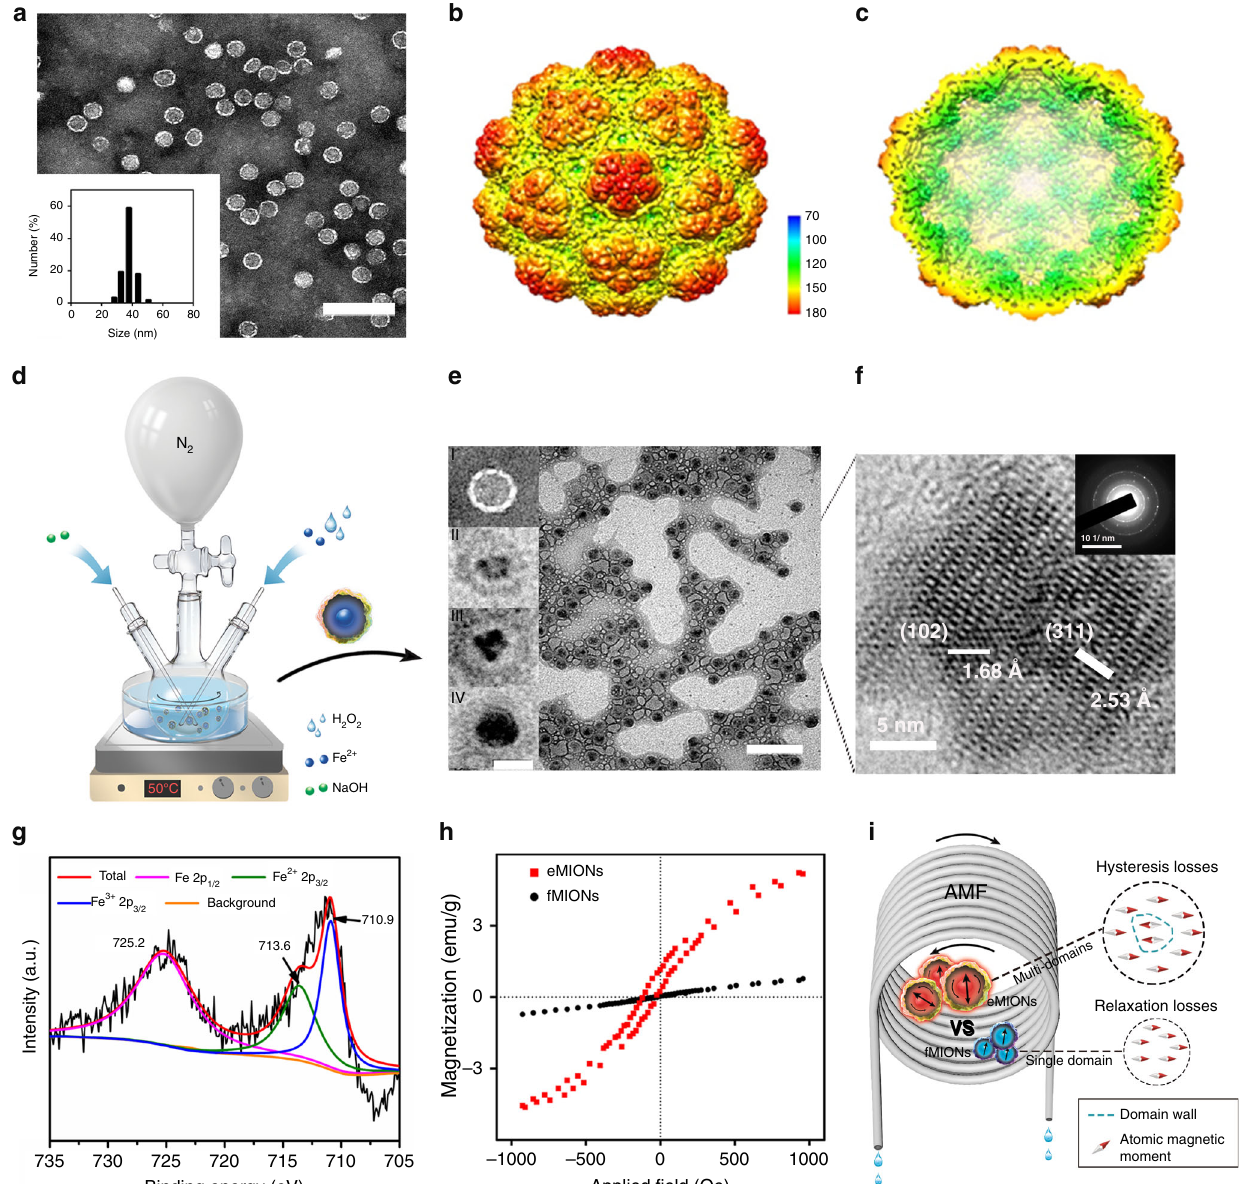
Fig. 2 Characterization of encapsulin-produced magnetic iron oxide nanocomposites (eMIONs). a Representative TEM image of encABC (Inset: DLS of encABC). Scale bar: 100 nm. b , c Isosurface representation of reconstructed nanoparticles color-coded according to the radial distance from the center (given in Å): b view from the outside; c cutaway view of the internal structure. d Schematic diagram of the biomimetic synthesis of eMIONs and the